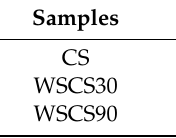
Figure 1. ( a ) 1 H NMR spectra of CS, WSCS30, and WSCS90 in DCl/D 2 O. ( b ) A comparison of 13 C NMR spectra of WSCS30 in CD 3 COOD/D 2 O obtained after dialysis against DI water (top) and 0.1 M NaCl solution (bottom), respectively. The peaks for trifluoroacetate ions are indicated by arrows. WSCS — water-soluble chitosan. Table 1. DDA of CS, WSCS30, and WSCS90.